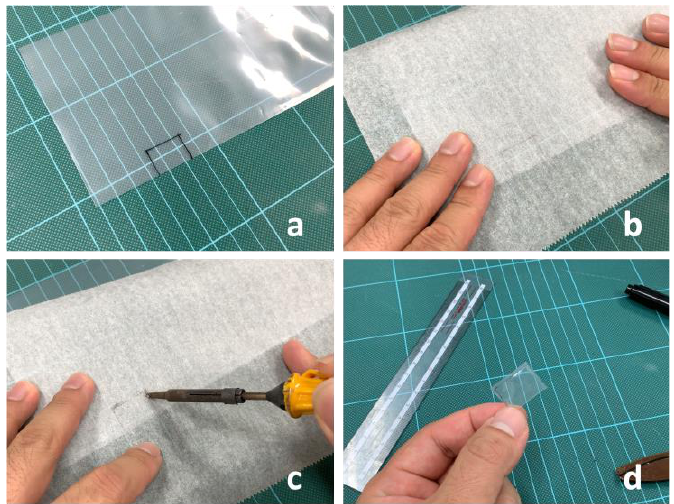
Figure 2. Fabricated pneumatic actuator. ( a ) A working fabricated pneumatic actuator. ( b ) Blue- print of the pneumatic actuator.